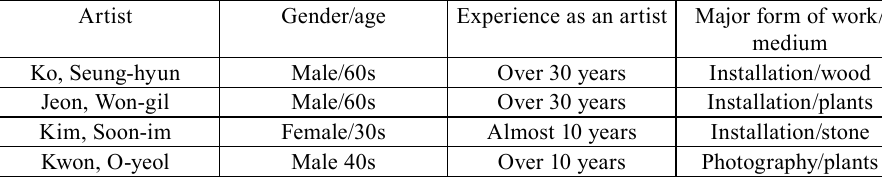
Table 1. Description of artist participants (created by author) artist gender/age experience as an artist Major form of work/ medium Ko, seung-hyun Male/60s over 30 years installation/wood jeon, Won-gil Male/60s over 30 years installation/plants Kim, soon-im female/30s almost 10 years installation/stone Kwon, o-yeol Male 40s over 10 years